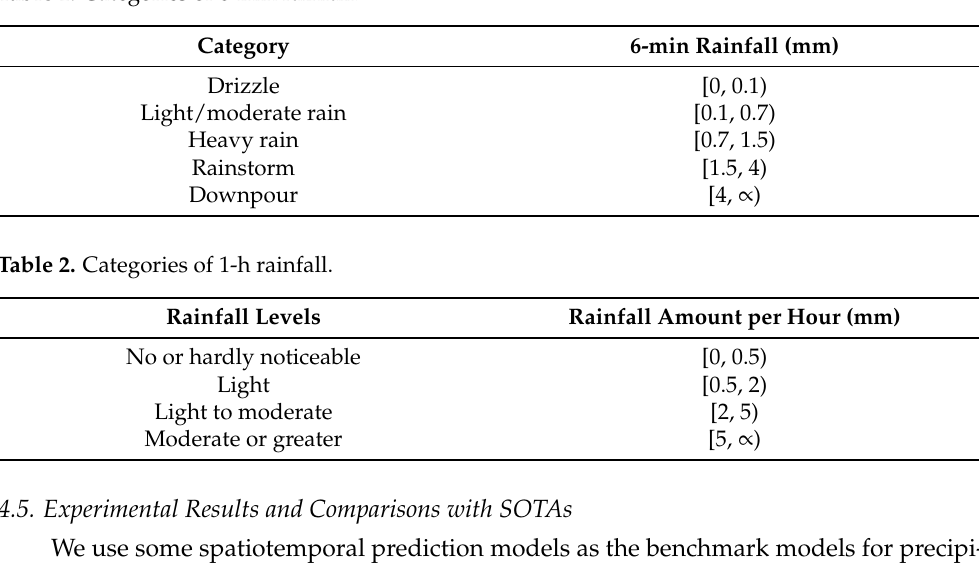
Table 1. Categories of 6-min rainfall.